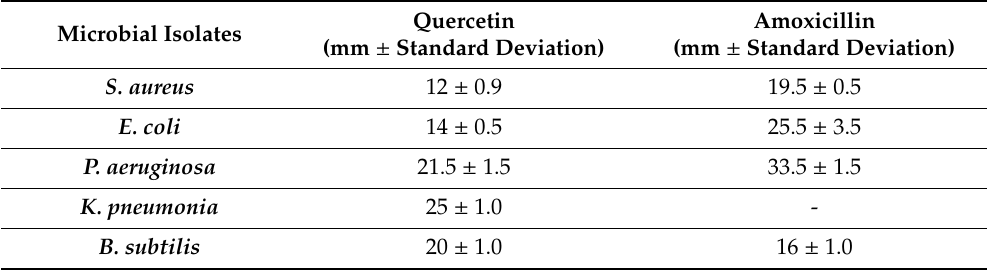
Table 1. Inhibition zone following treatment of isolates with